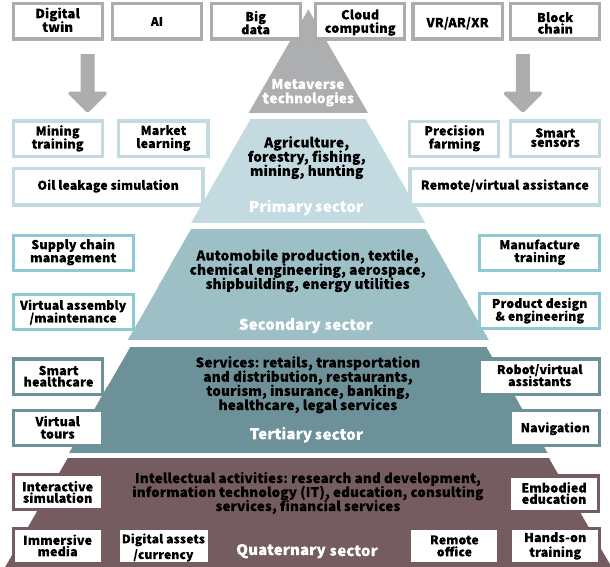
Fig. 2 Current technologies and applications in Metaverse